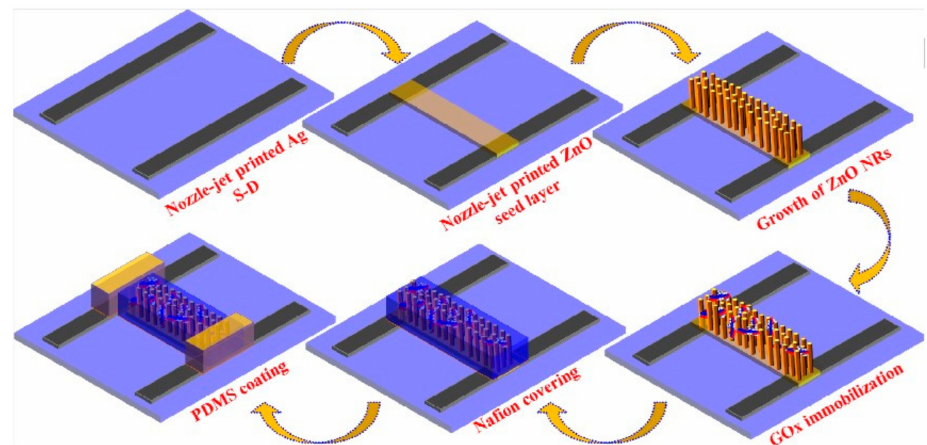
Figure 3. Fabrication process of ZnO-FET biosensors by the nozzle-jet printing method [67]. Reprinted from Journal of Colloid and Interface Science, 506, Bhat et al., Nozzle-Jet Printed Flexible Field-E ff ect Transistor Biosensor for High Performance Glucose Detection, 188–196, Copyright 2017, with permission from Elsevier Elsevier.